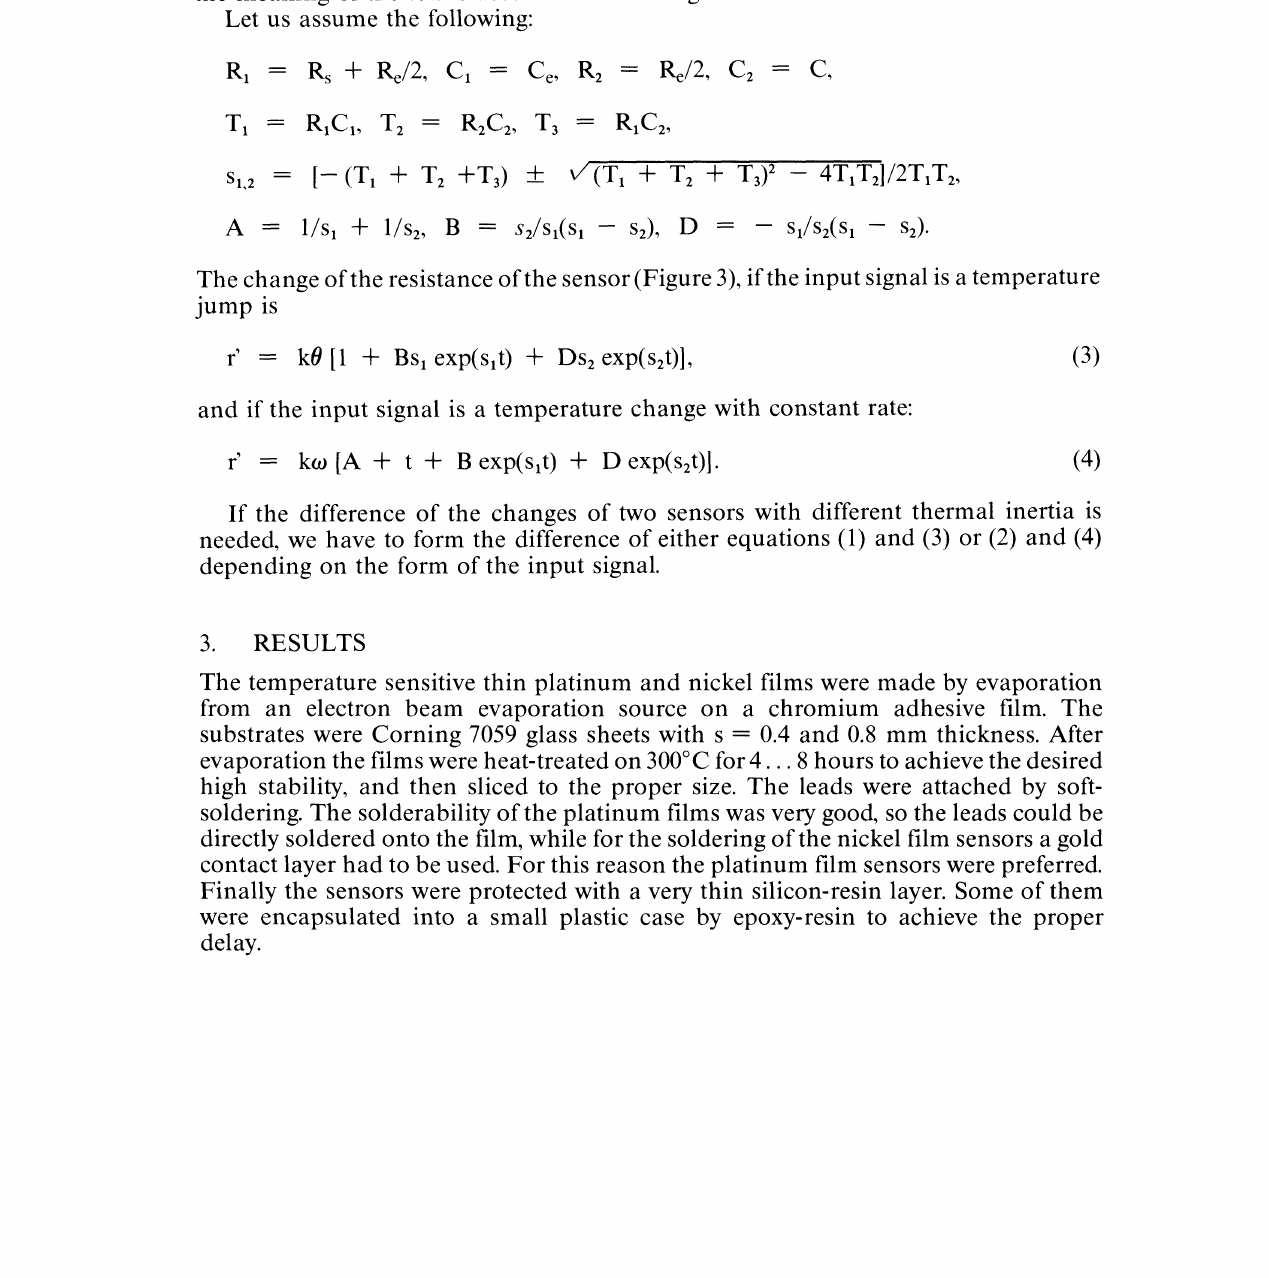
Rs Rel2 Rel2 " co ic’T" surface encapsulation sensorl R Se-S Rs- K-- 4As c,( As e Ce Cede Ar(Se-S) C=cAs